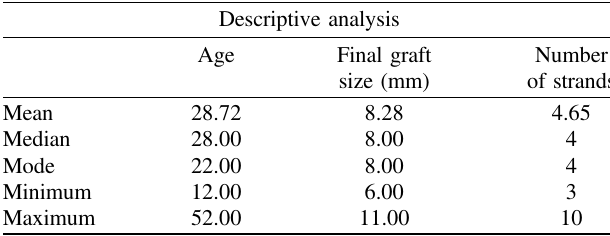
Figure 1. Histogram of Age and distribution plot of different age groups. Around 50% of all ACL patients were at the age between 21 and 30, while 30% of them were between 31 and 40 years old. Table 1. Descriptive analysis of age and fi nal graft